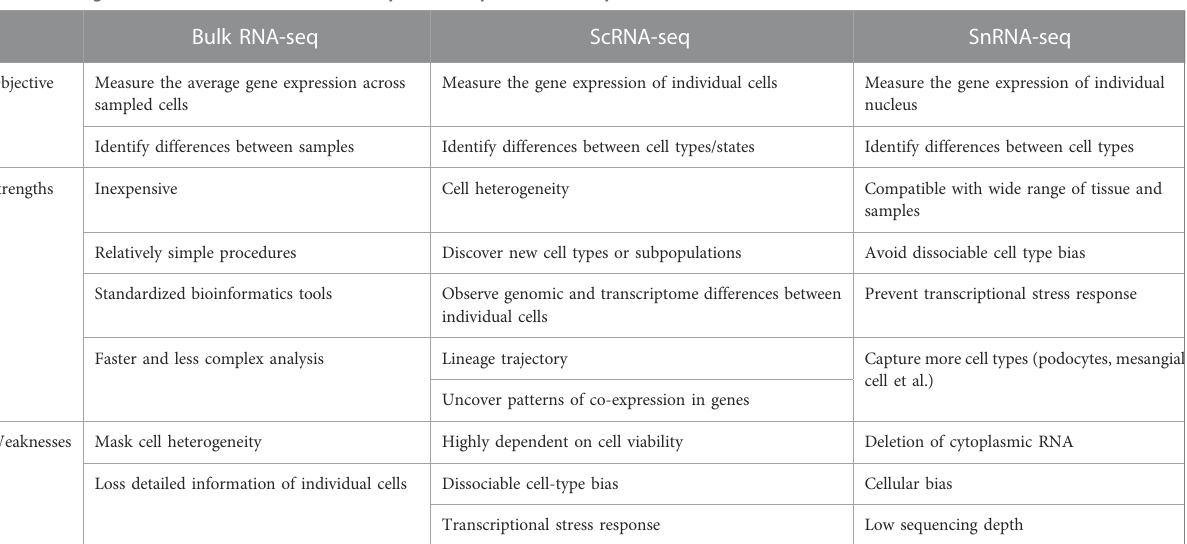
TABLE 1 Strengths and weaknesses of bulk RNA-seq, scRNA-seq and